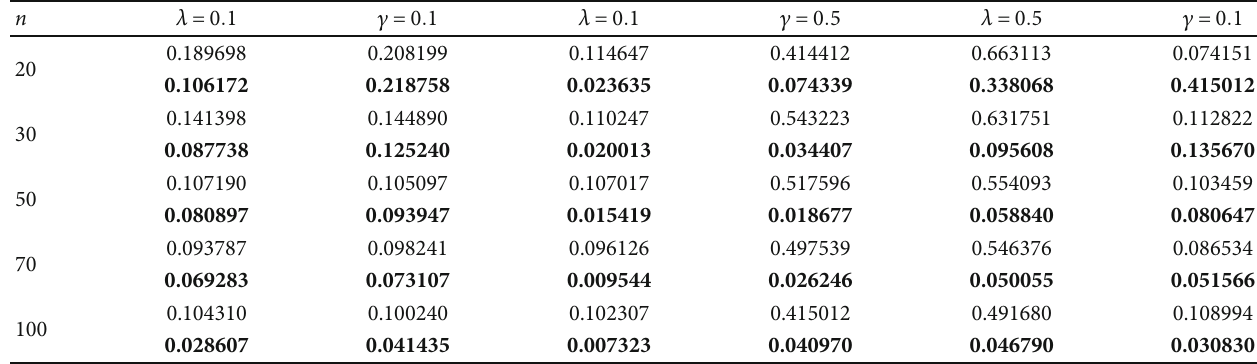
Table 4: BEs and PRs under ELF and noninformative prior using λ = 0 : 1, 0 : 5 and γ = 0 : 1, 0 : 5, 0 : 1 .